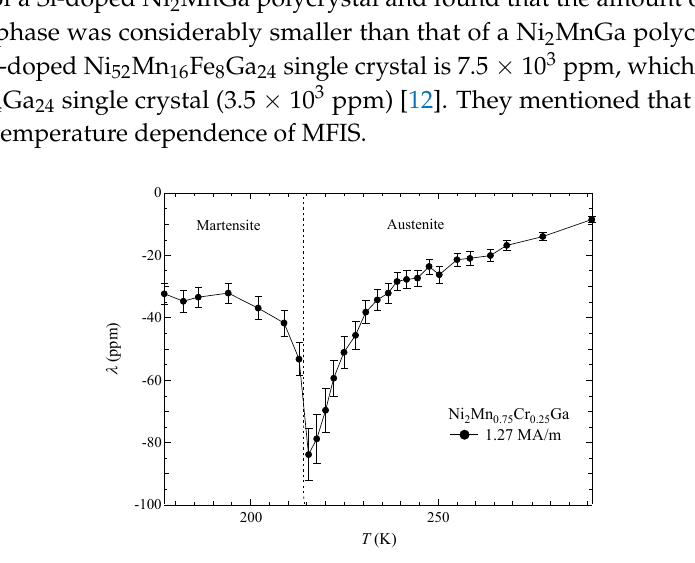
Figure 7. Temperature dependence of the magnetostriction λ for the x = 0.25 alloy.